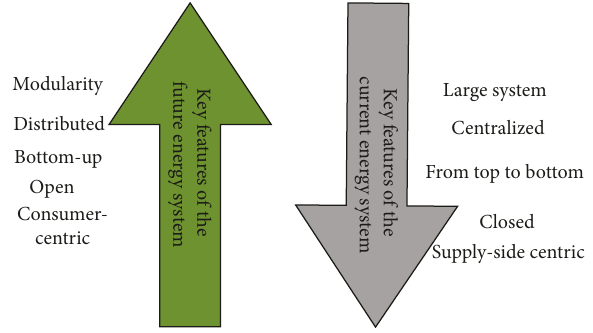
Figure 3: Difference between the current power system and the new energy power system.